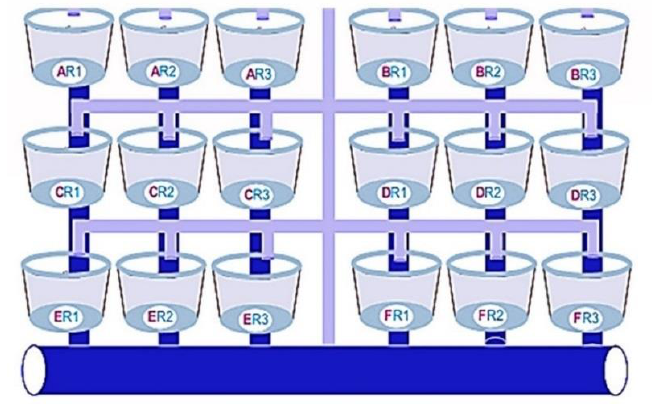
Figure 2. Experiment design and rearing system during the